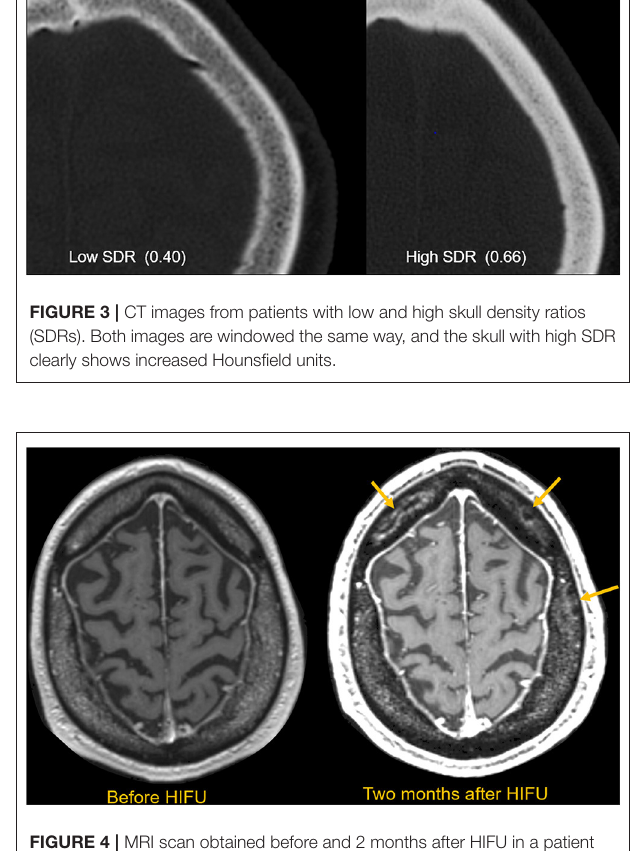
FIGURE 4 | MRI scan obtained before and 2 months after HIFU in a patient requiring extended sonications to make a durable thalamic lesion. Multiple serpiginous marrow lesions compatible with infarctions are subsequently seen in the marrow space, as indicated with yellow arrows. These lesions are asymptomatic, but